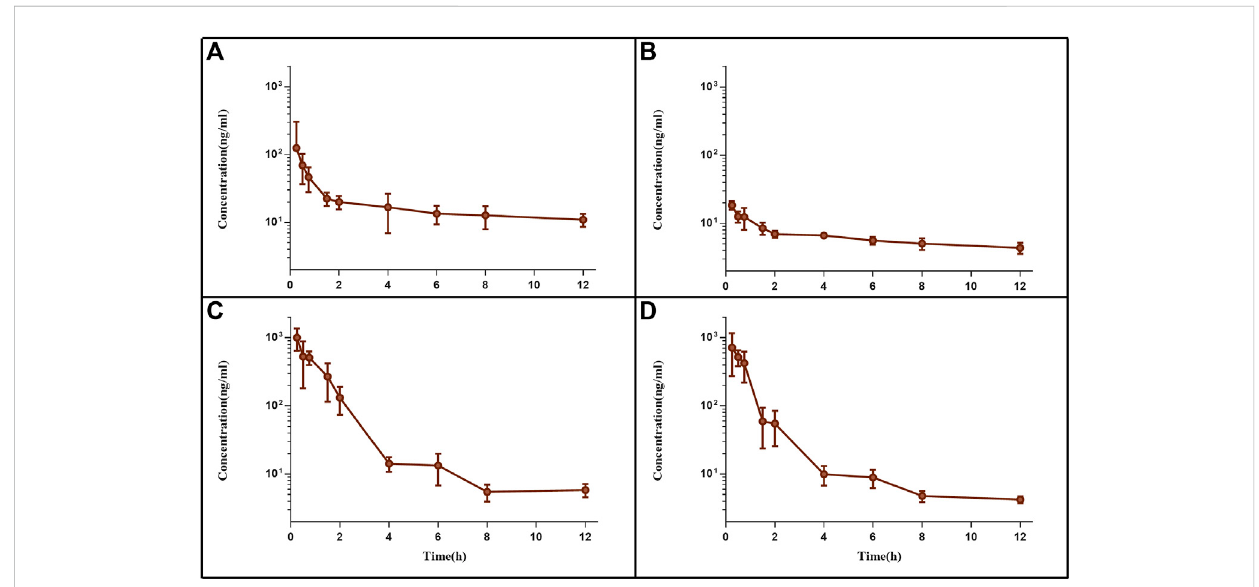
FIGURE 4 The plasma pharmacokinetic curves of evodiamine (EDM) and dehydroevodiamine (DEDM). The injection of EDM (5, 2.5 mg/kg) and DEDM (10, 5 mg/kg)wasinjectedthroughtailveinofmice.Bloodwascollectedat0.25,0.5,1,2,3,4,6,8,and12 hafterthedose(with7miceateachtimepoint).The collected samples were centrifuged for 10 min at 3,000 rpm and plasma from supernatants was transferred to other tubes. The plasma samples were analysed by HPLC-MS/MS and draw pharmacokinetic curves. (A) EDM (5 mg/kg); (B) EDM (2.5 mg/kg); (C) DEDM (10 mg/kg); (D) DEDM (5 mg/kg); Data are shown as the mean + SD, n = 7.